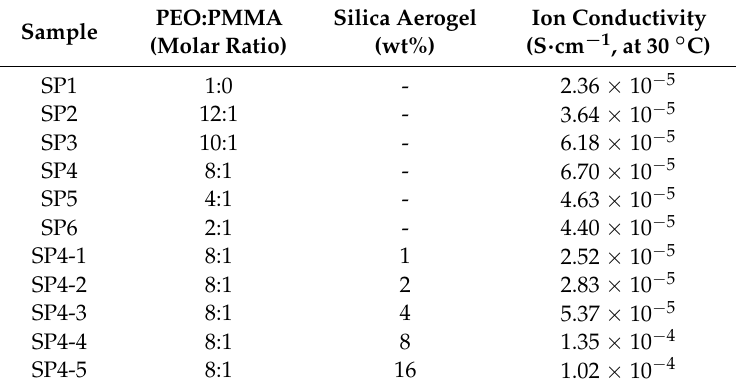
Figure 4. AC impedance spectra of solid polymer electrolyte samples. Table 2. Lithium-ion conductivities of solid polymer electrolyte samples.